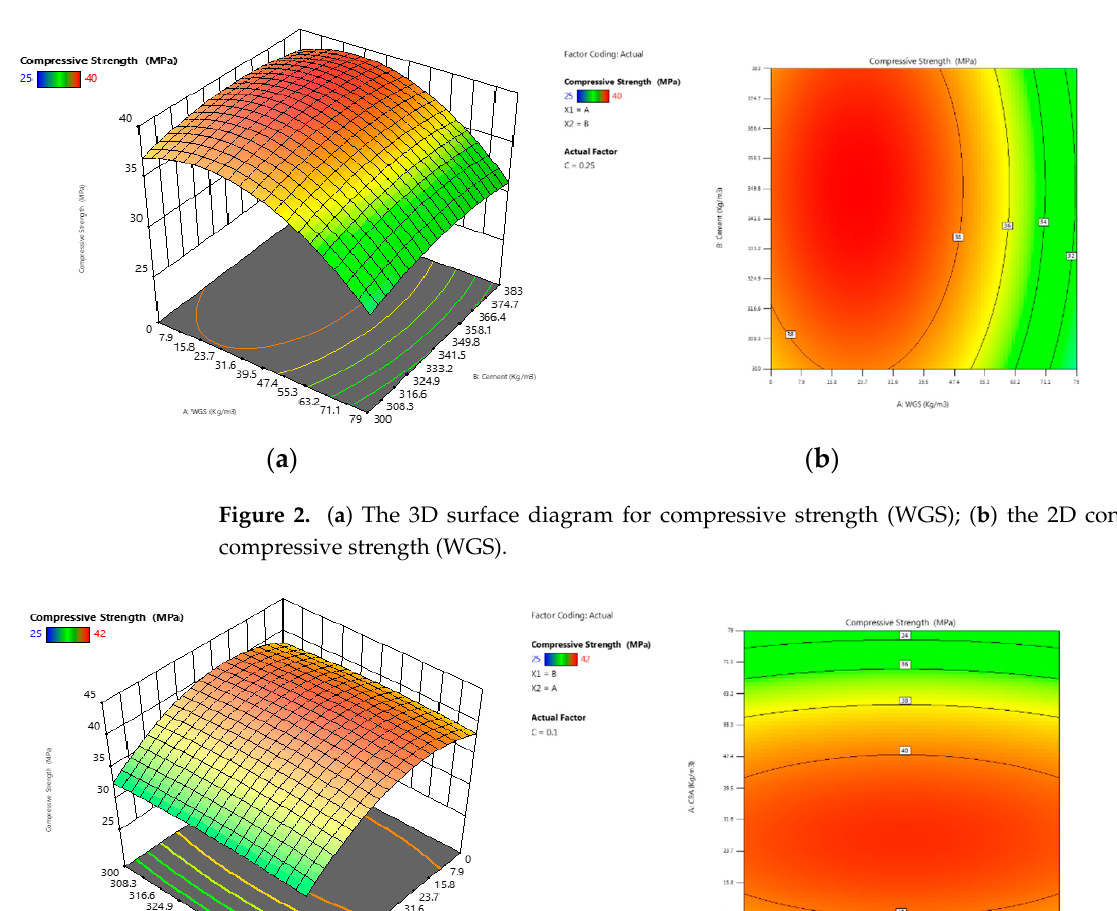
Figure 2. ( a ) The 3D surface diagram for compressive strength (WGS); ( b ) the 2D contour for com- pressive strength (WGS).